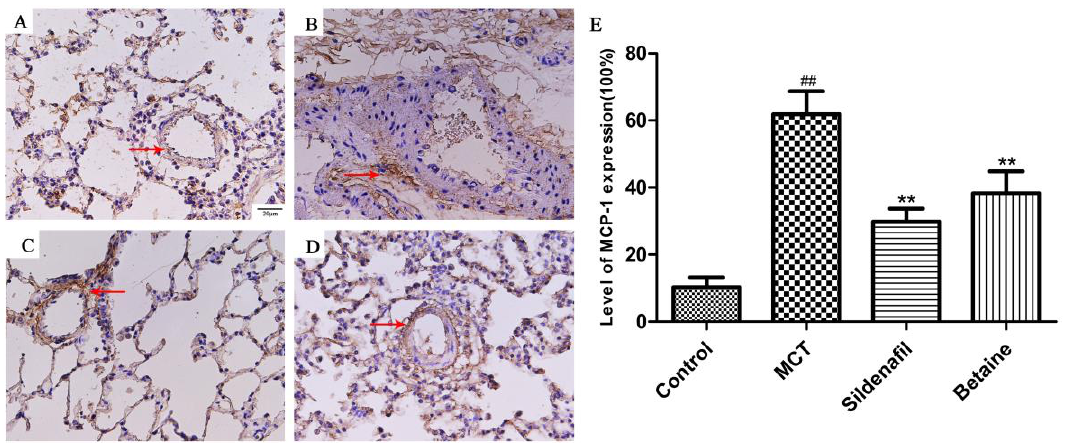
Figure 7. ( A – D ) Effects of betaine on the expression of MCP-1 in lungs (magnification × 400). Data are shown as mean ± standard error of the mean ( n = 6). ## p < 0.01 vs control group; ** p < 0.01 vs MCT group. ( A ) Control group, ( B ) MCT group, ( C ) betaine 400 mg/kg group, ( D ) The bar graph reflects level of MCP-1 expression.